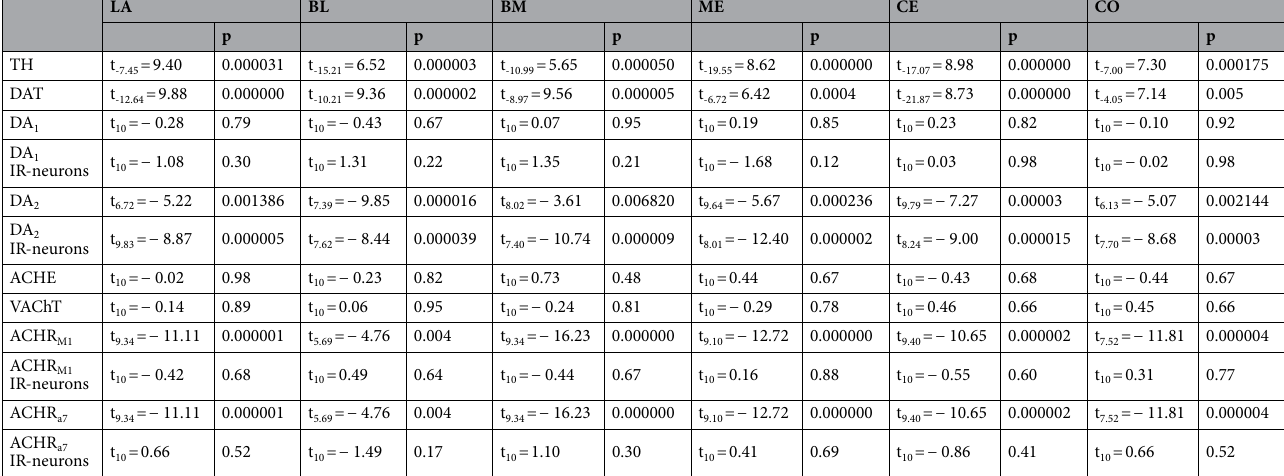
Table 1. Statistical analysis of studied markers between ERβ −/− and ERβ +/+ mice in the amygdala. IR